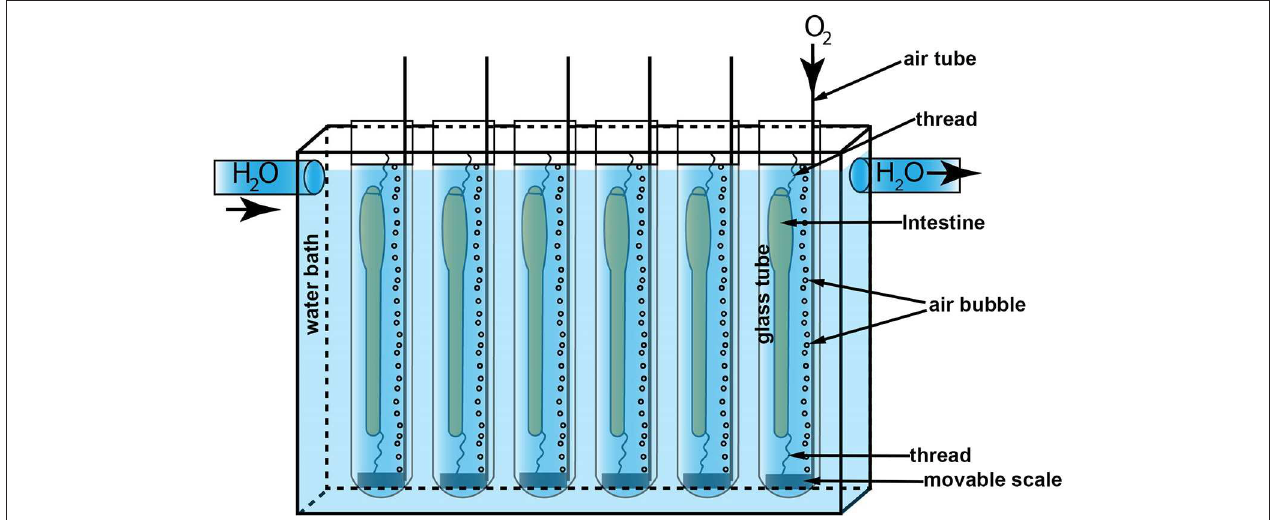
FIGURE 1 | The in vitro experiment setup. The water bath (201 × 124 × 50mm) was circulated with 14 ◦ C water pumped from a thermal chamber. Six glass tubes ( Φ 20mm) containing 25mL Ringer’s solution were immersed in the water bath. An air tube was mounted to each glass tube to supply oxygen to the solution. A scale was attached to the anal end of the intestines with surgical thread and the oral end of intestine was closed and attached to a hanger. This kept the intestine straight for measuring intestinal diameter but also allowed for longitudinal contractions.